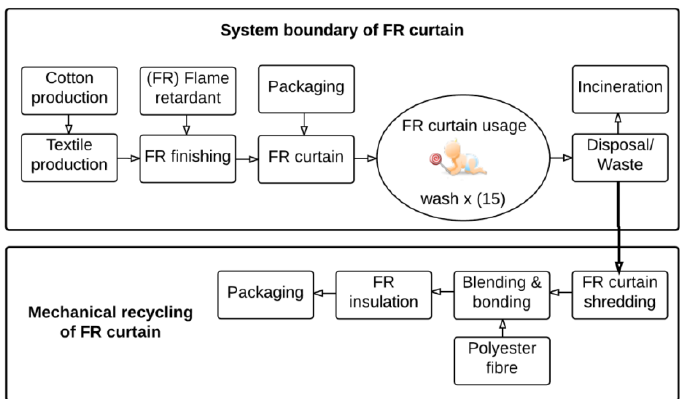
Figure 3. The process map used for carbon emissions from the virgin production of FR curtains and recycled FR insulation.